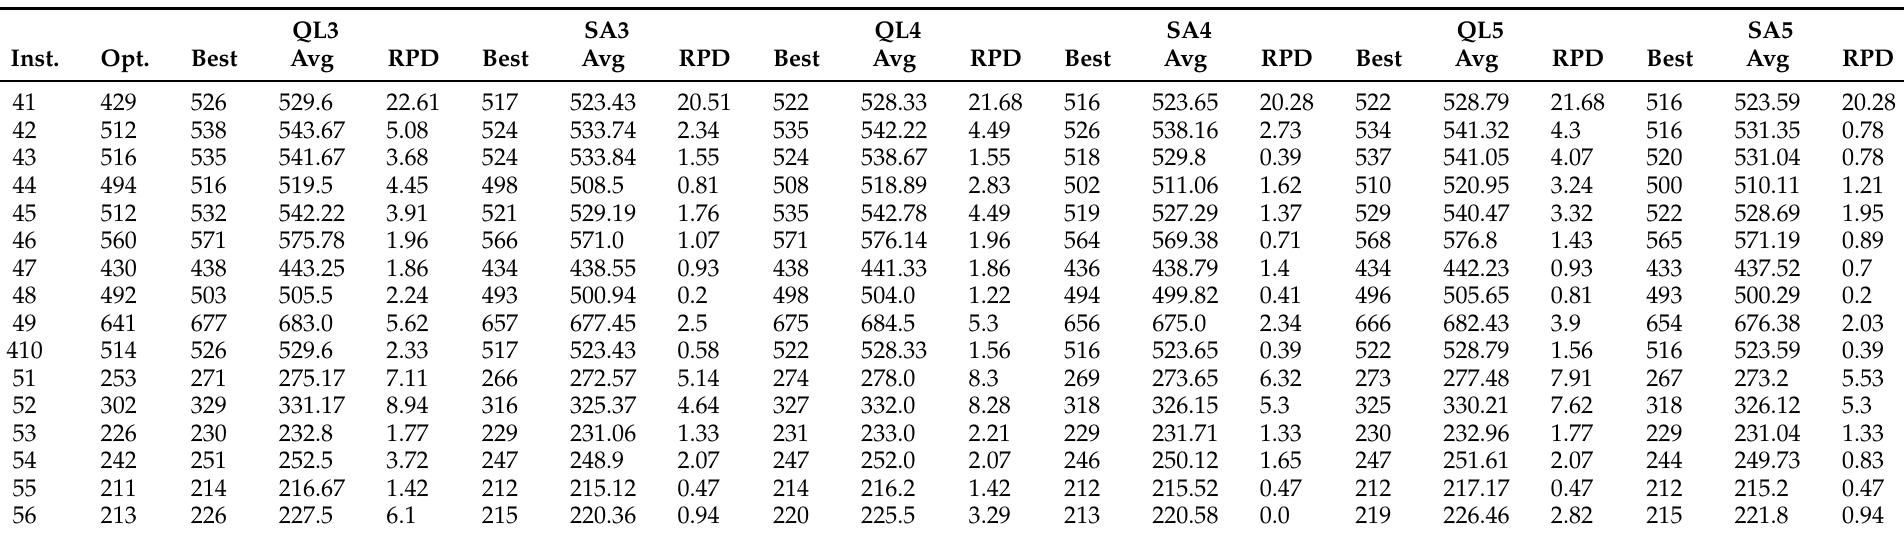
Table 12. Result comparison with GWO employing the approaches QL3, SA3, QL4, SA4, QL5, and